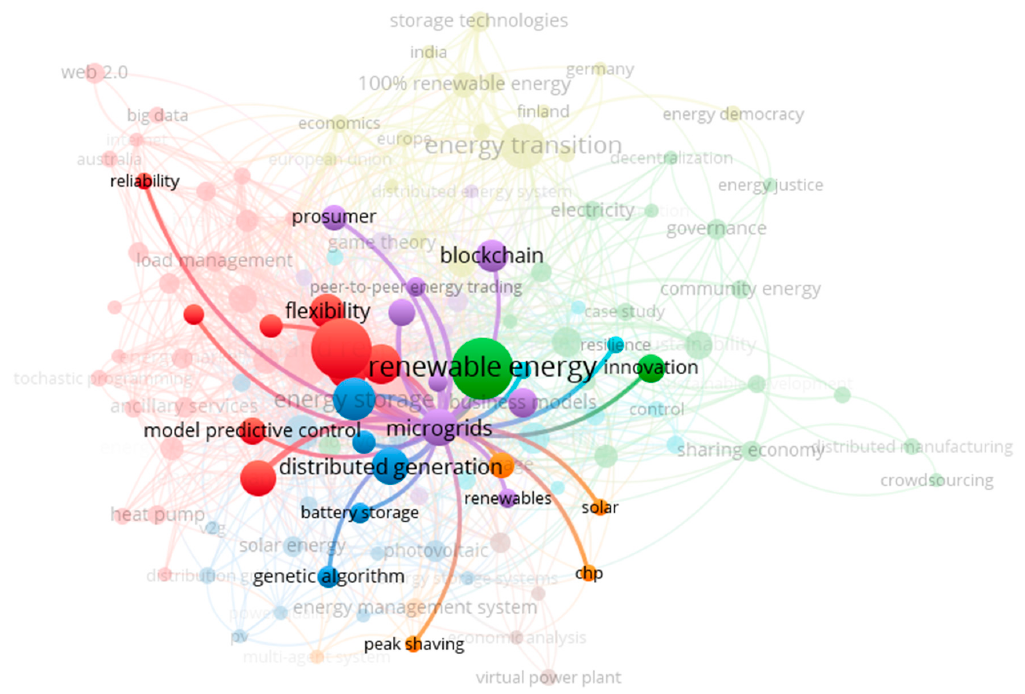
Figure 16. Highlighting the connections around ‘microgrids’.